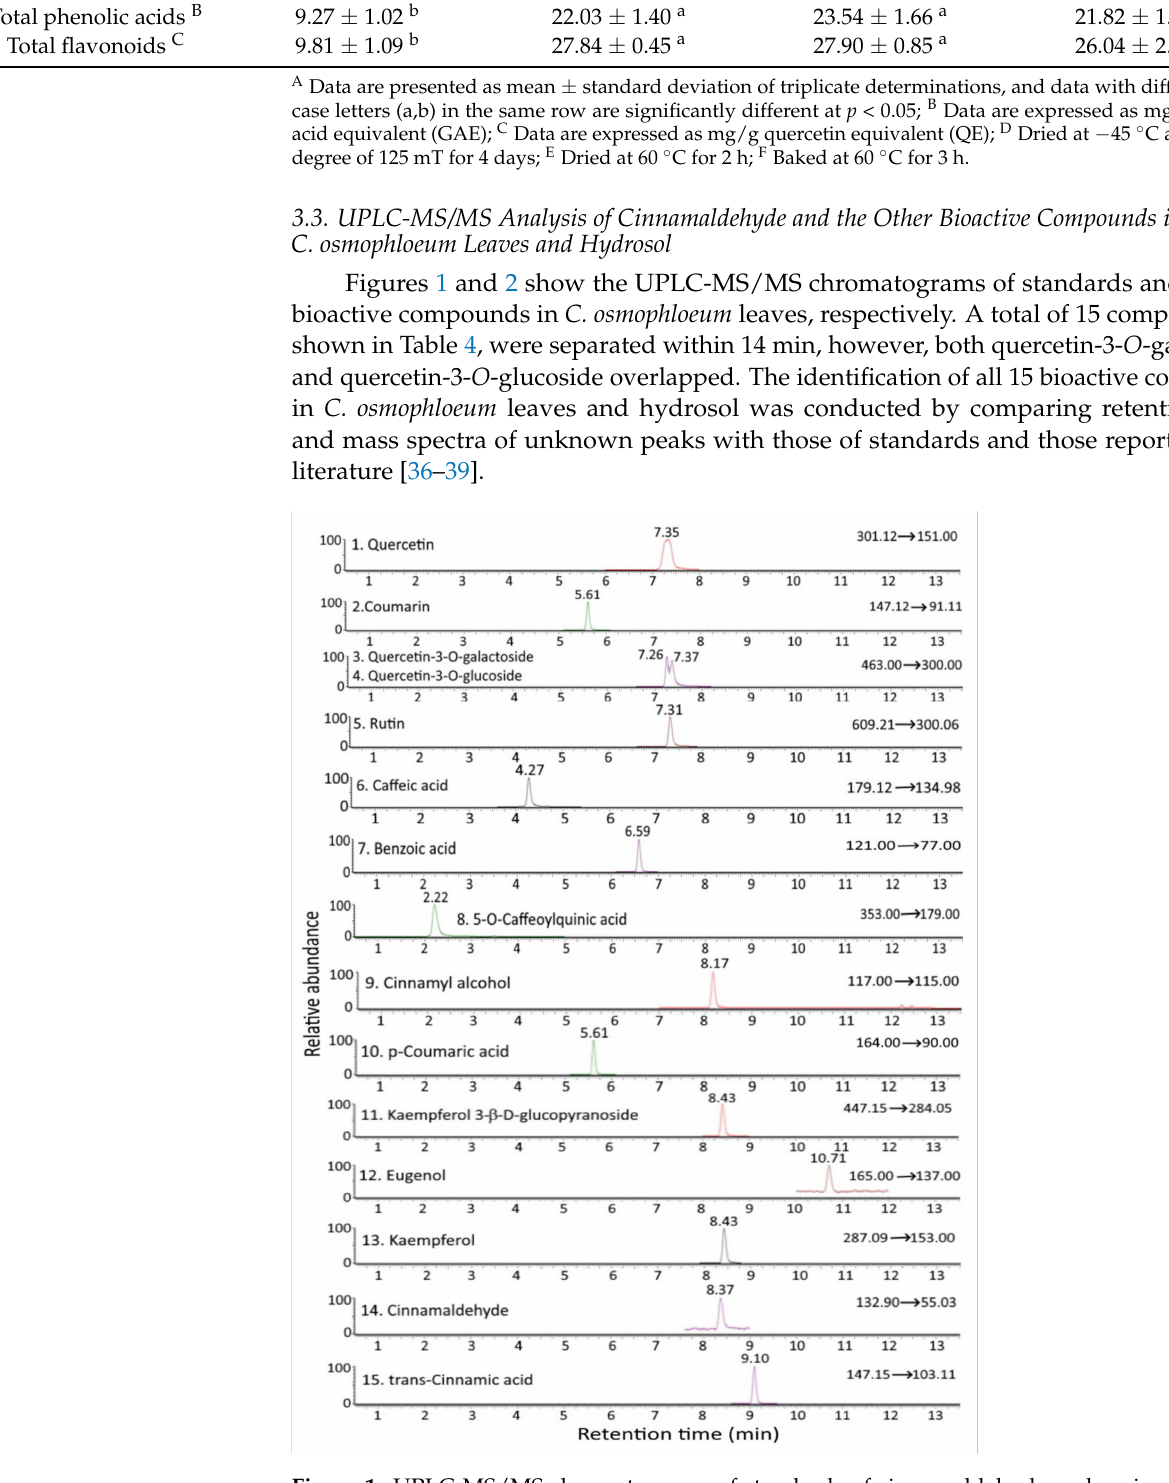
Figure 1. UPLC-MS/MS chromatograms of standards of cinnamaldehyde and various bioactive compounds as detected by MRM